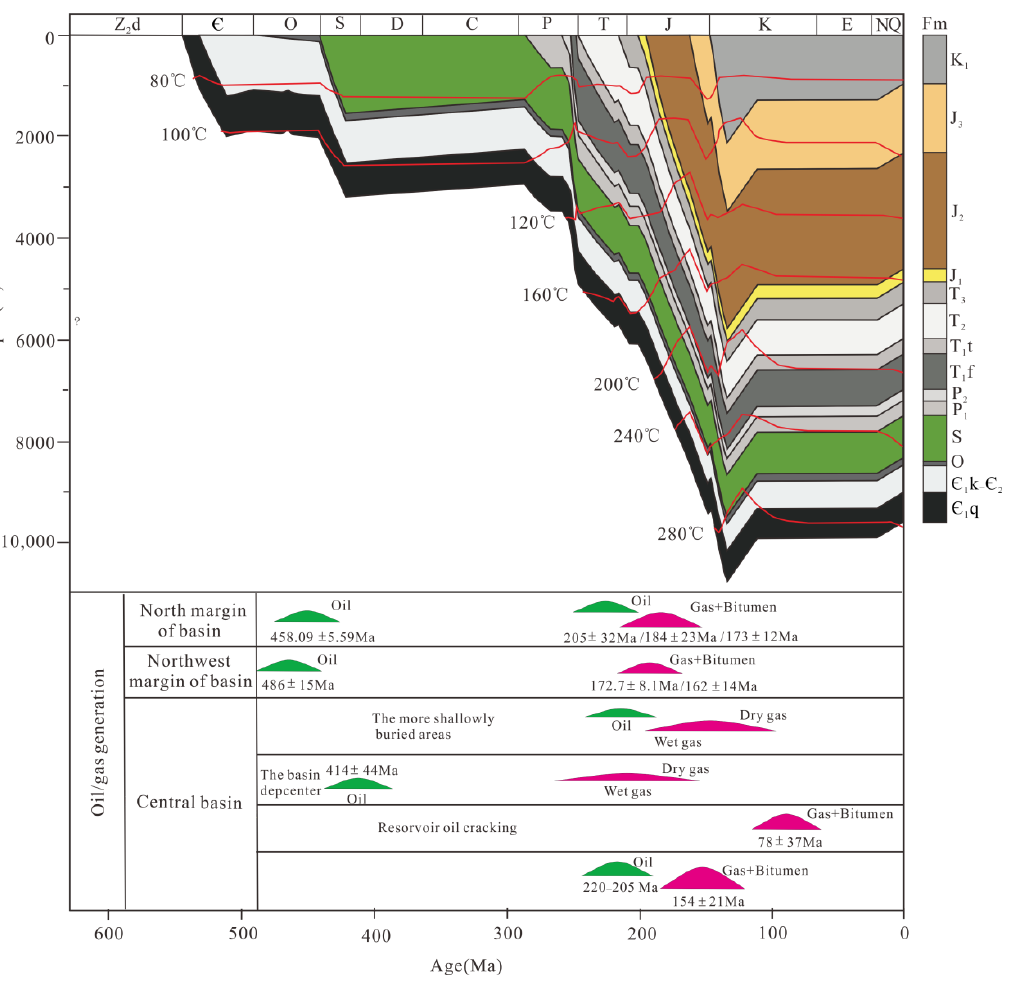
Figure 10. The burial history of source rocks and hydrocarbon accumulation times. The ages of oil/gas generation in the northern and northwestern margins of the Sichuan Basin are from Shen et al. (2019) [56] and Ge et al. (2018) [57], and those in the central Sichuan Basin are from Shi et al. (2020) [43] and Su et al. (2020, 2022) [58,60]. Based on Rb‒Sr isotope dating of six sphalerite sam ples from the Heiqu, Xuequ, and Shandouya, Xiong et al. (2018) [31] obtained a metallogenic age of 411 ± 10 Ma, which